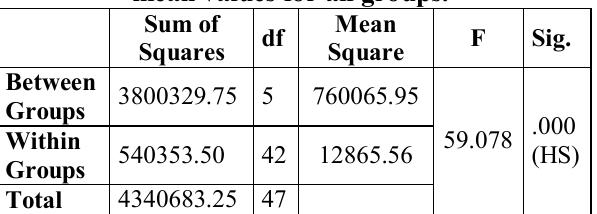
Table 2: ANOVA test of fracture resistance mean values for all groups. Sum of Squares